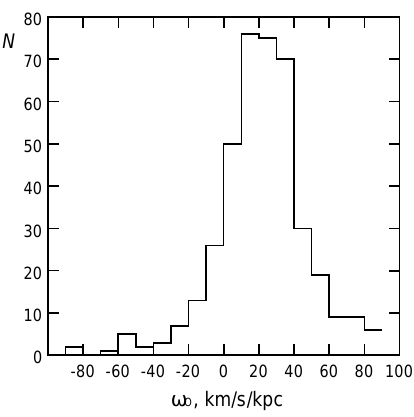
Fig. 3. The distribution of individual ω 0 estimates for open clusters of the